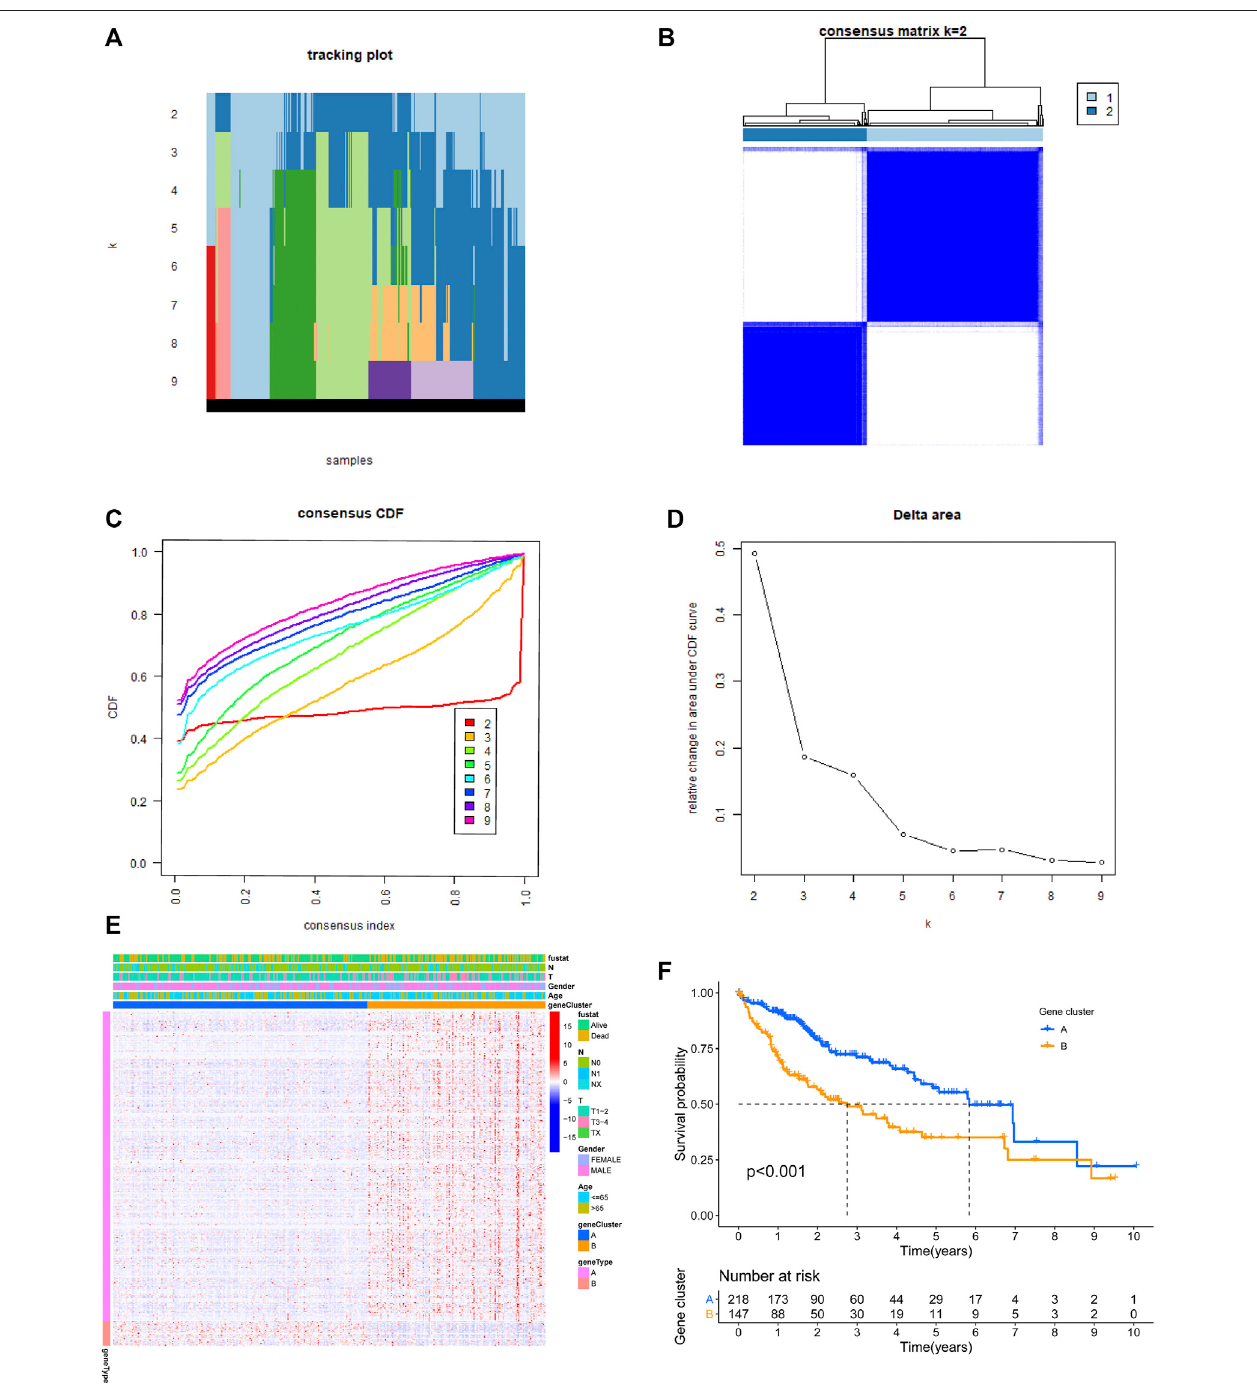
FIGURE2| Twoclustersbasedontheexpressionlevelofangiogenesis-relatedimmunegenes(ari-genes)intheTCGAcohort. (A) Thesampledistributionchanged withk valued 2 to9. (B) Relative change inarea under theCDF curve with k (cid:2) 2. (C) Consensus clusteringcumulative distribution function (CDF) with k valued 2to 9. (D) Consensus clustering matrix for k (cid:2) 2. (E) Heatmap of ari-genes between two clusters in the TCGA cohort. (F) Kaplan – Meier survival curves for clusters A and B of the TCGA dataset ( p < 0.001). A and B represent different immune statuses.